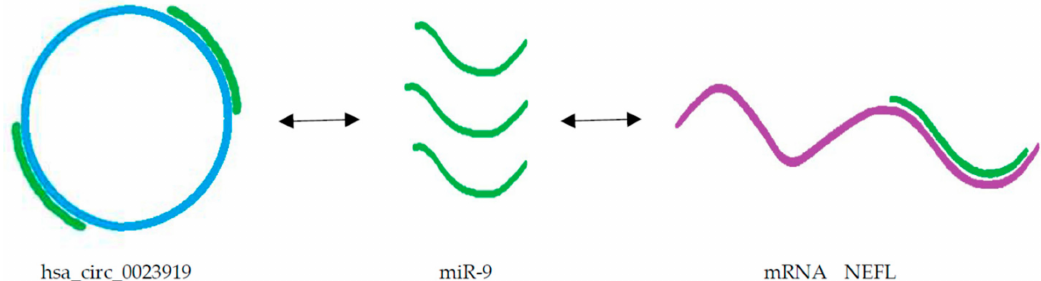
Figure 2. Potential circRNA–miRNA–mRNA axis for amyotrophic lateral sclerosis (ALS). This axis represents endogenous competition between circRNA hsa_circ_0023919 and mRNA NEFL for binding of miR-9. circRNA hsa_circ_0023919 sponges miR-9, which regulates metabolism of neurofilament (NEFL)